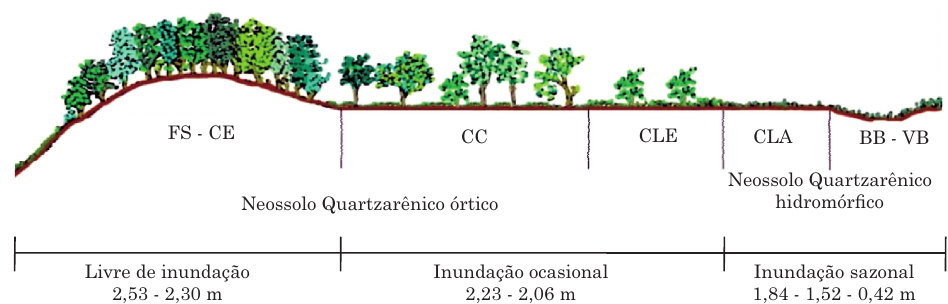
Figura 1. Representação esquemática das diferentes fitofisionomias, conforme tipo de solo, regime de inundação e cotas médias das áreas estudadas. FS: floresta semidecídua; CE: cerradão; CC: campo cerrado; CLE: campo limpo com Elyonorus muticus ; CLA: campo limpo com Axonopus purpusii ; BB: borda de baía; e VB: vazantes e baixadas. Fonte: Adaptado de Cardoso (2008).